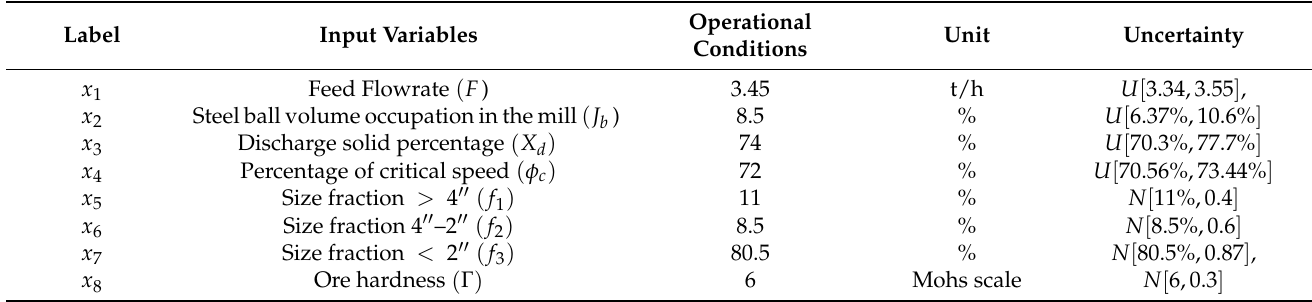
Table 2. Input variables from the SAG mill